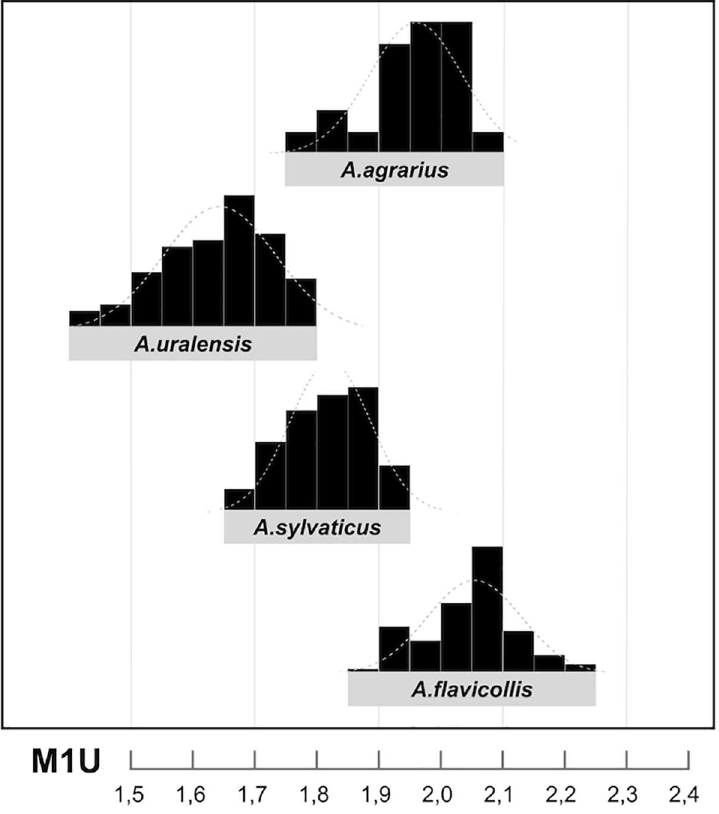
Fig 4. Frequency diagram of metric variation (M1 length = M1U) in the Recent sample of particular Apodemus spp. from the Czech